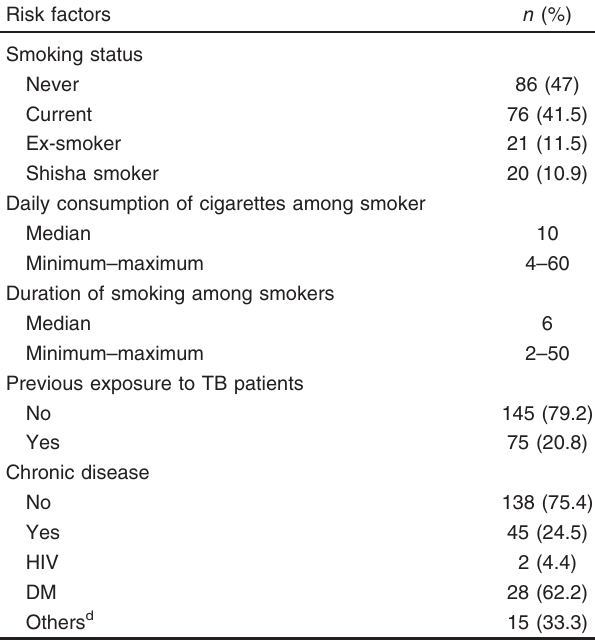
Table 3 Frequency of tuberculosis risk factors among studied patients ( N = 183) Risk